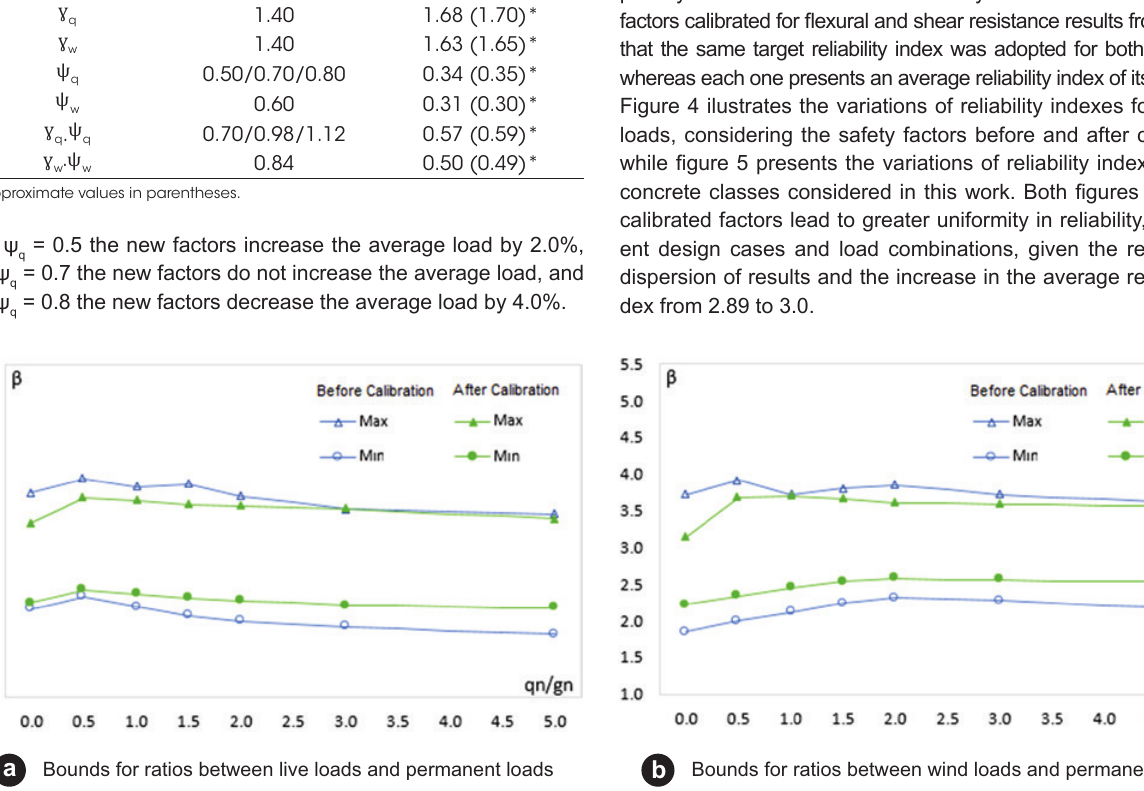
Reliability index bounds for shear resistance of reinforced concrete beams and